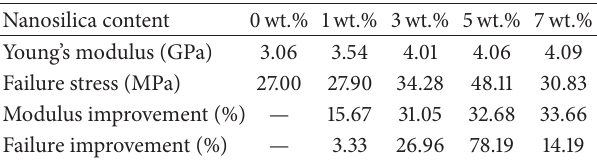
Table 1: The tensile properties of epoxy filled with silica nanoparti- cles for